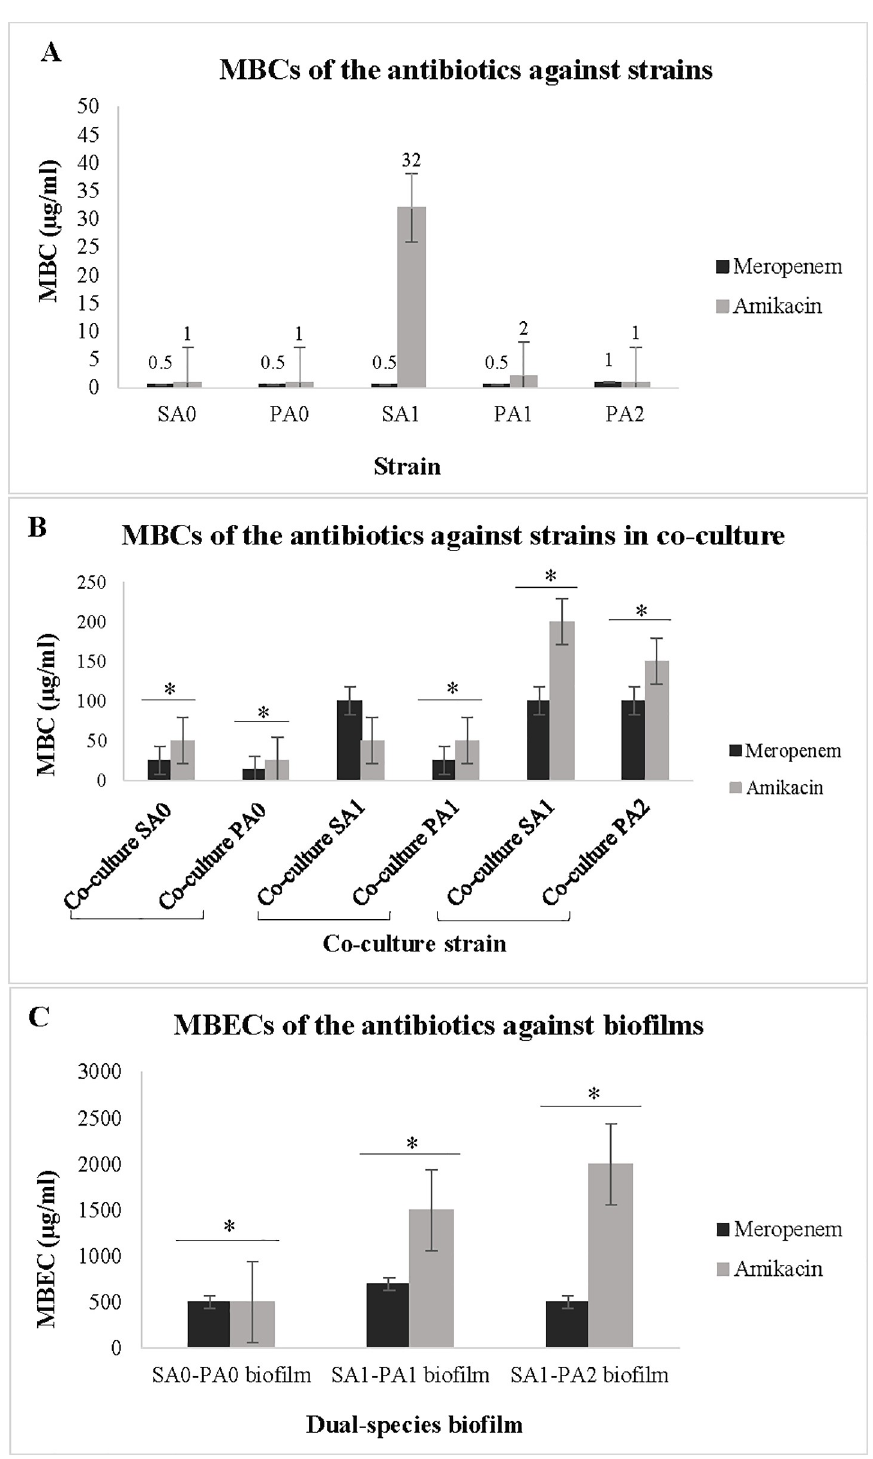
Fig 5. MBCs in different culture conditions. Data show the MBCs of meropenem and amikacin against monoculture strains, co-culture strains, and MBECs of the antibiotics against S . aureus-P . aeruginosa biofilms. A shows MBC values obtained against monocultures of SA 0 , PA 0 , SA 1 , PA 1 , and PA 2 isolates. B indicates MBCs of the antibiotics against SA 0 , PA 0 , SA 1 , PA 1 , and PA 2 strains when they were co-cultured (co-cultures: SA 0 -PA 0 , PA 1 -SA 1 , and PA 2 -SA 1 ). C shows MBECs of the antibiotics against dual-species biofilms of SA 0 -PA 0 , PA 1 -SA 1 , and PA 2 -SA 1. With the exception